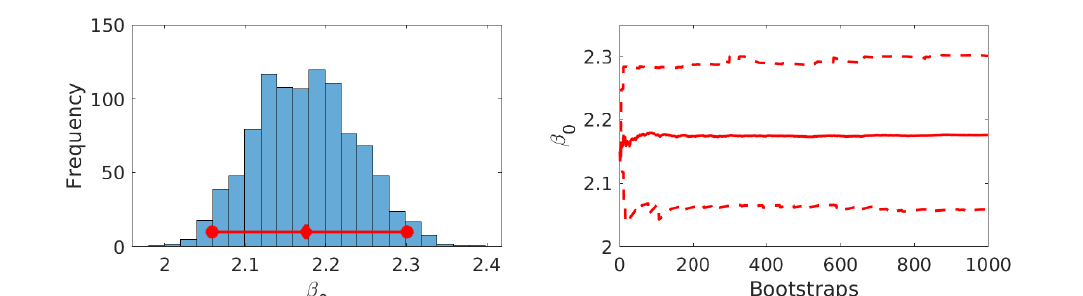
(cid:2) (cid:3) β 0.025 , β 0.975 0 0 (dashed) and ¯ β 0 (solid) over